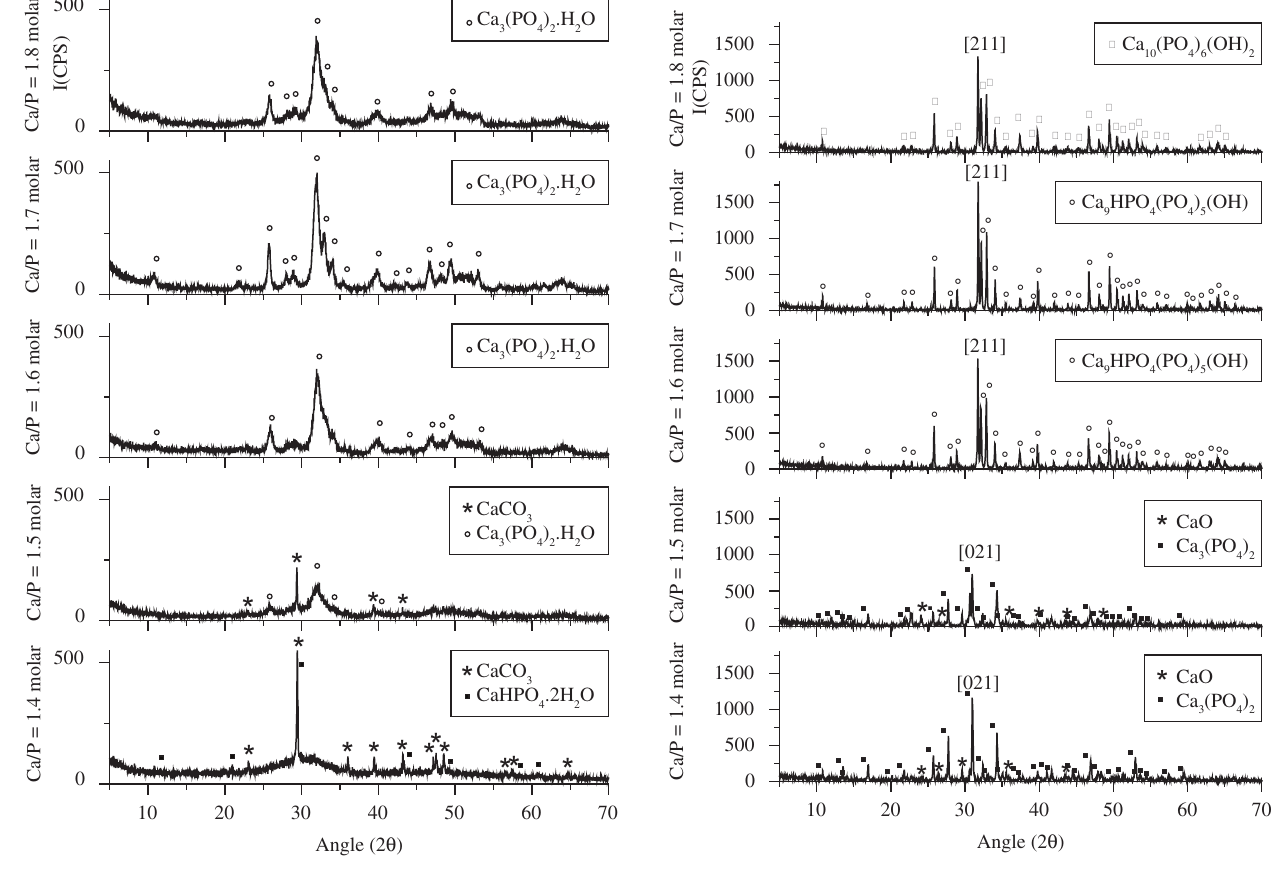
Figure 3. Spectra of X ray diffractometry on powders recovered from drying in rotating evaporator for the different compositions (peaks per second as a function of 2 θ ).